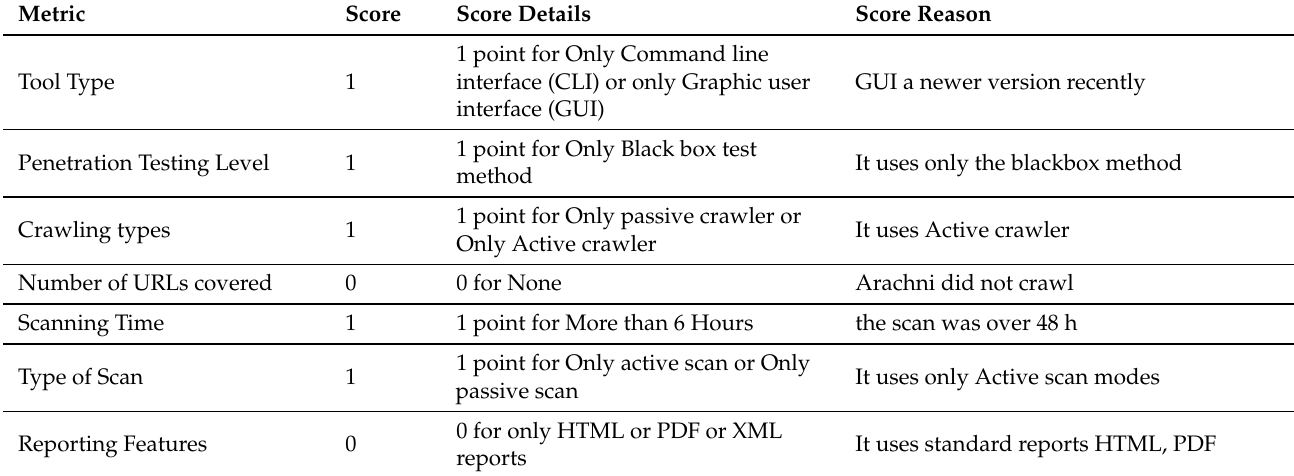
Table A5. Results of benchmarking Arachni using our framework in